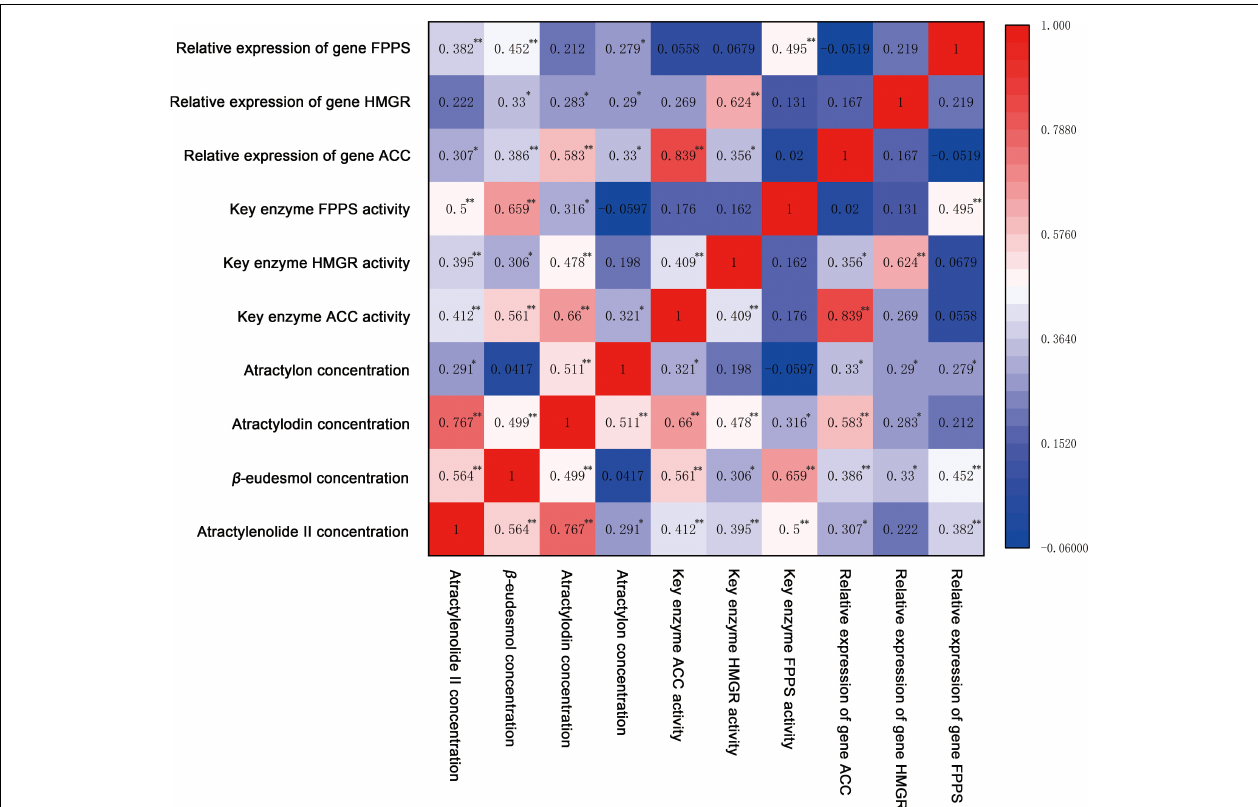
FIGURE 7 | The correlation analysis of pharmacodynamic components with key enzyme activity and gene relative expression of A. chinensis under different NPK combination applications. ∗ indicates significant correlation at p < 0.05 (bilateral), ∗∗ indicates significant correlation at p < 0.01 (bilateral).